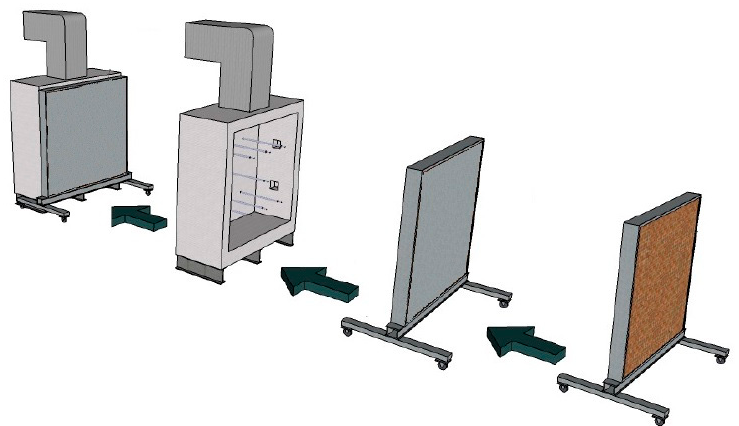
Figure 4. Attaching the samples to the test furnace.